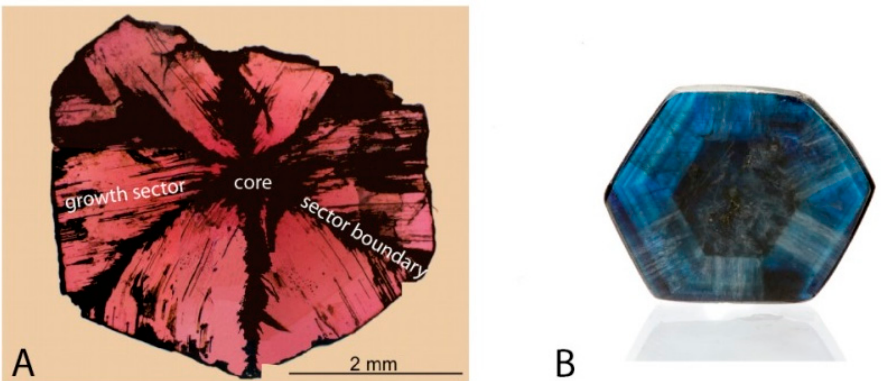
Figure 10. The trapiche texture of corundum. ( A ) Photomicrograph in transmitted light of a trapiche ruby from Mong Hsu, Myanmar (Photo: Virginie Garnier) and ( B ) aspect of a “trapiche-like” sapphire from southern Africa (2 cm × 1.8 cm × 0.2 cm, 13.46 cts). Photo: Louis-Dominique Bayle © le Règne Minéral.